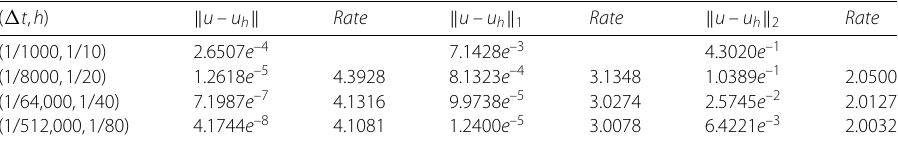
Table 3 The error for different time step (cid:3) t and space step h at t =